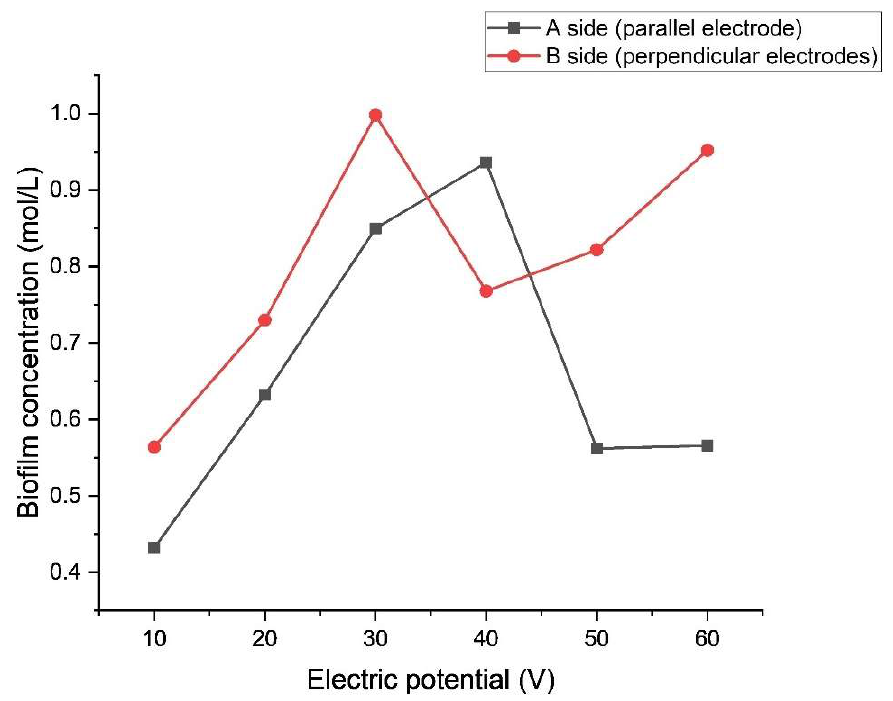
Figure 7. Graphical representation of the biofilm concentration inside the A and B parts of the channel as a function of the applied electric potential difference.